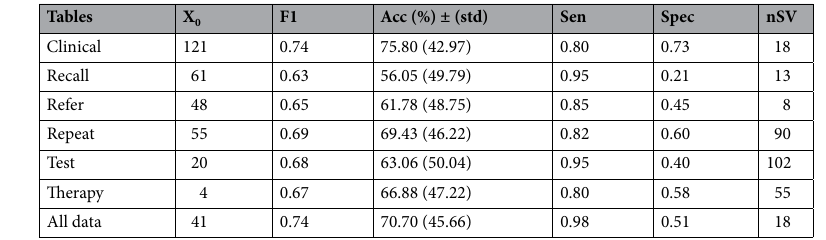
Table 2. Best results obtained from classification with single kernels constructed from the datasets, where X